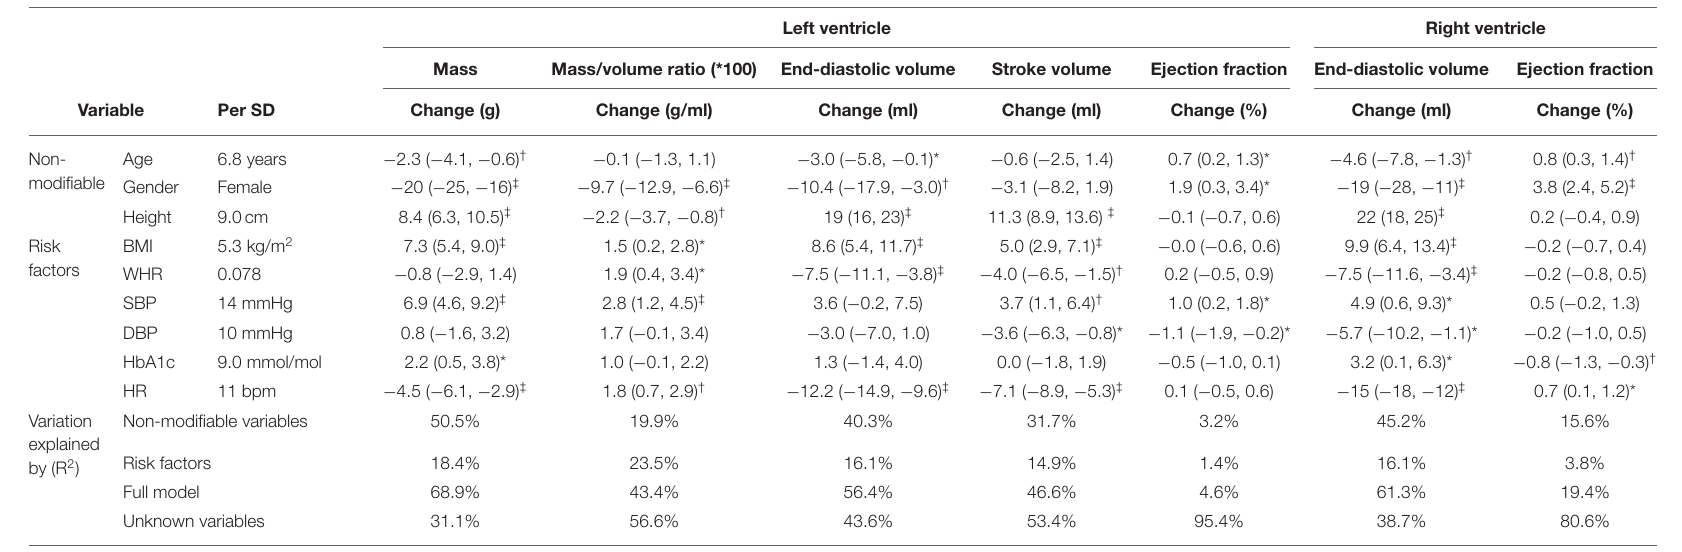
TABLE 2 | Multivariate linear regression models for cardiac morphology and